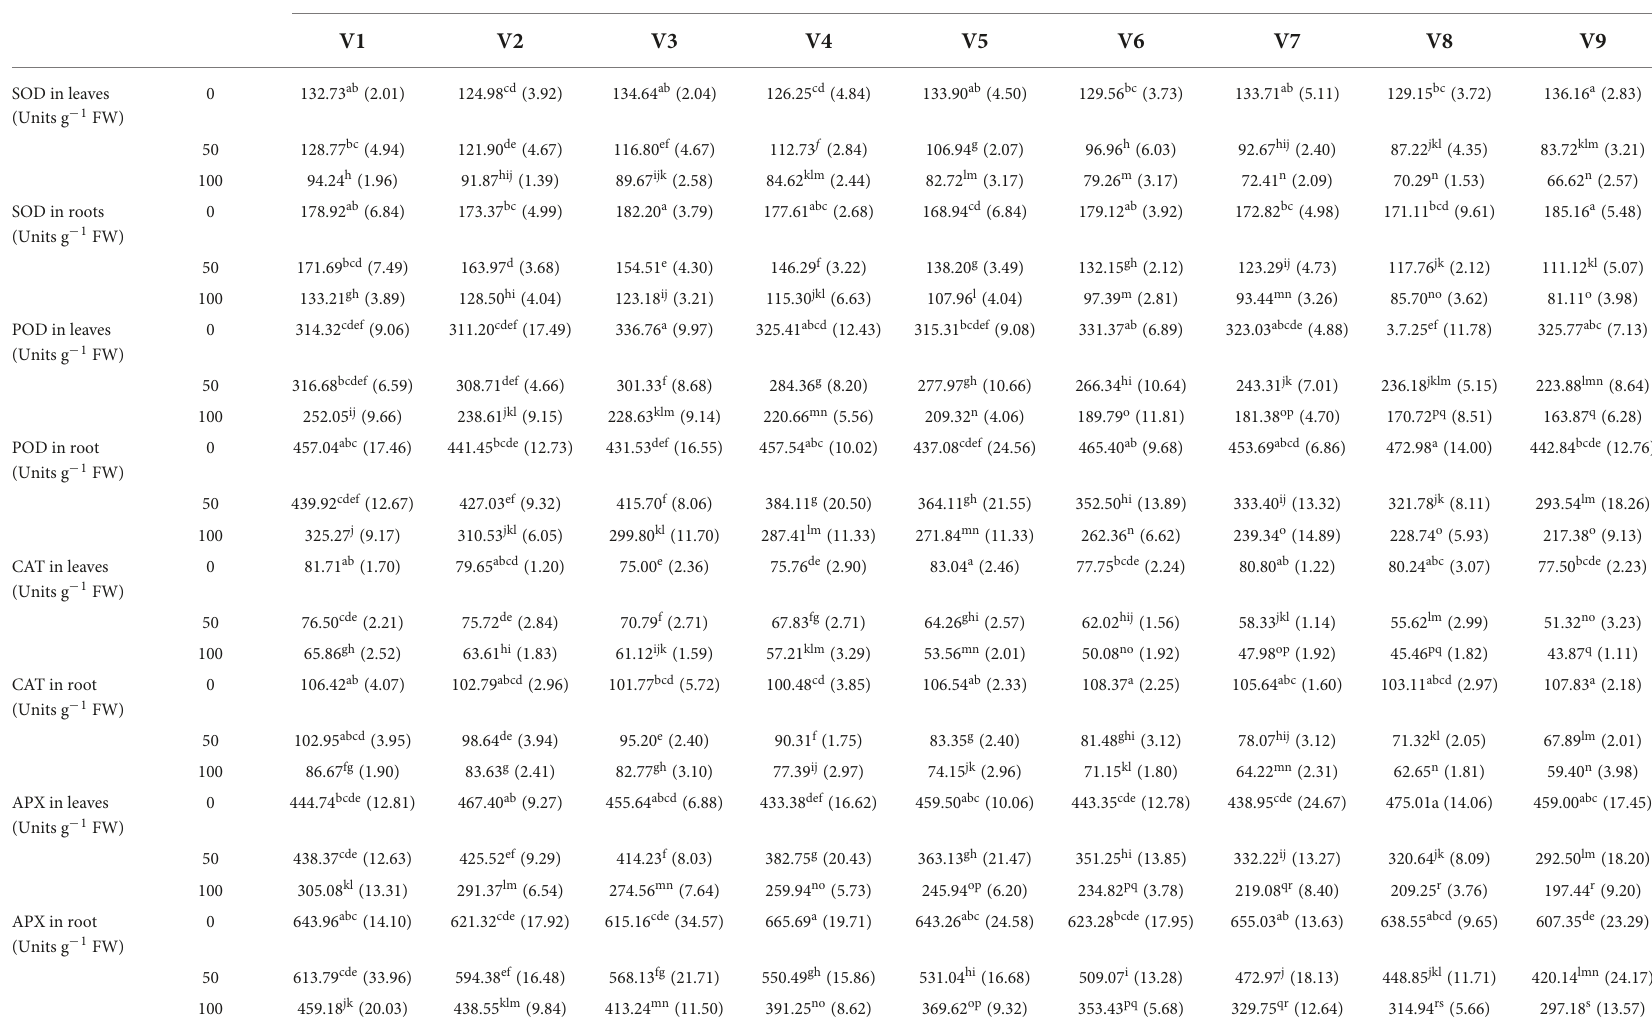
TABLE 3 Effect of different concentrations of NaCl on the contents of antioxidant enzyme activities of different barley genotypes.